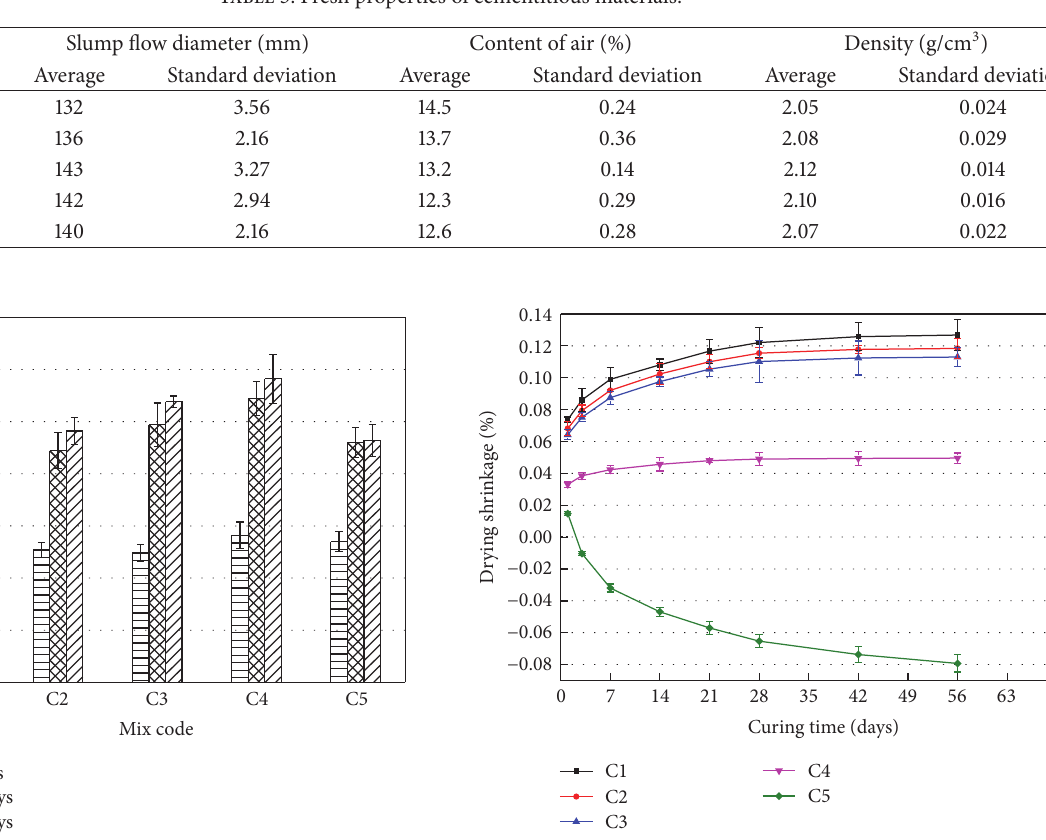
Figure 4: Development of splitting tensile strength of designed mixes.